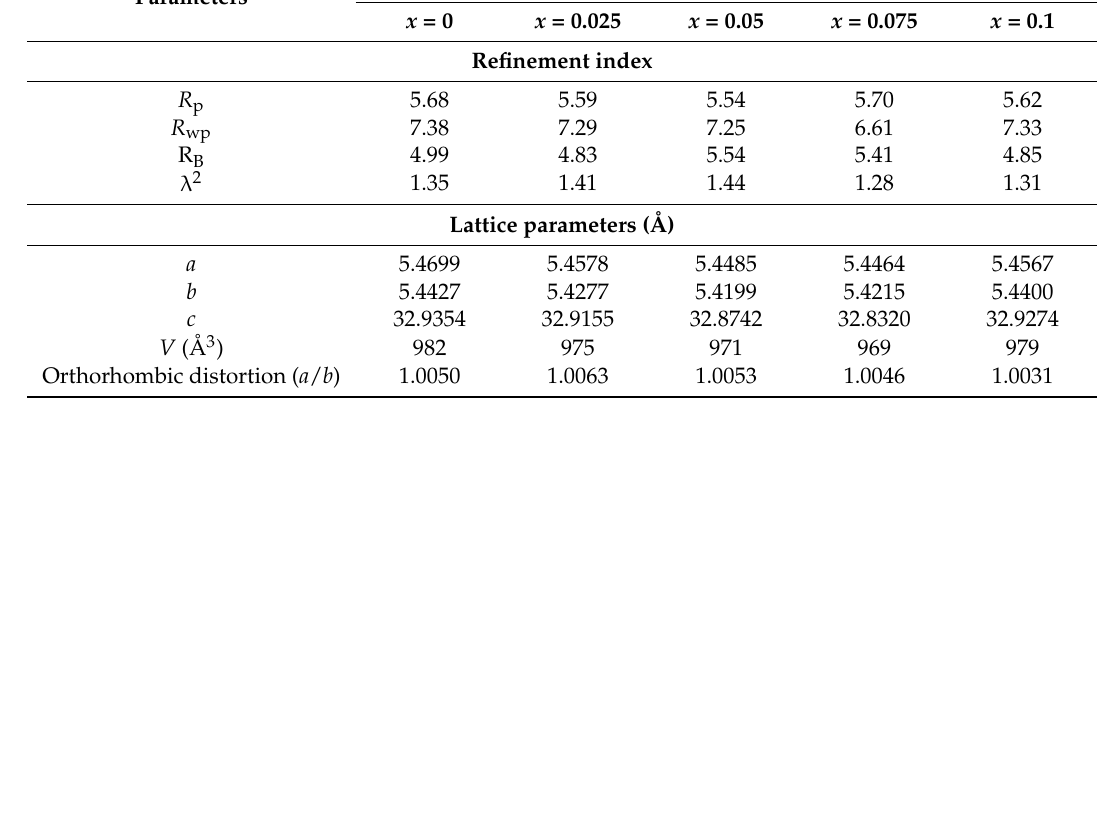
Table 2. Rietveld refinements for the crystal structure of BTW x -0.2Cr at 295 K.